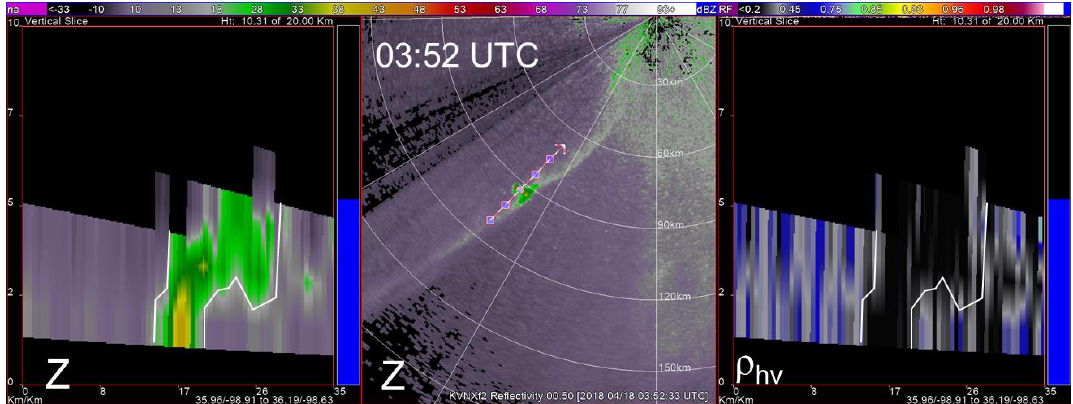
Figure 10. ( Left ) Vertical cross-section (RHI) of the Z field at 03:52 UTC. The line in the conical scan (middle panel, 0.5° elevation) indicates the location of the RHI plot. ( Right ) Same as in the left panel but the vertical cross-section of ρ hv . One color bar extends over the two images of Z and indicates categories in dBZ. The color bar over the ρ hv field indicates categories, and heights are above ground level in km.